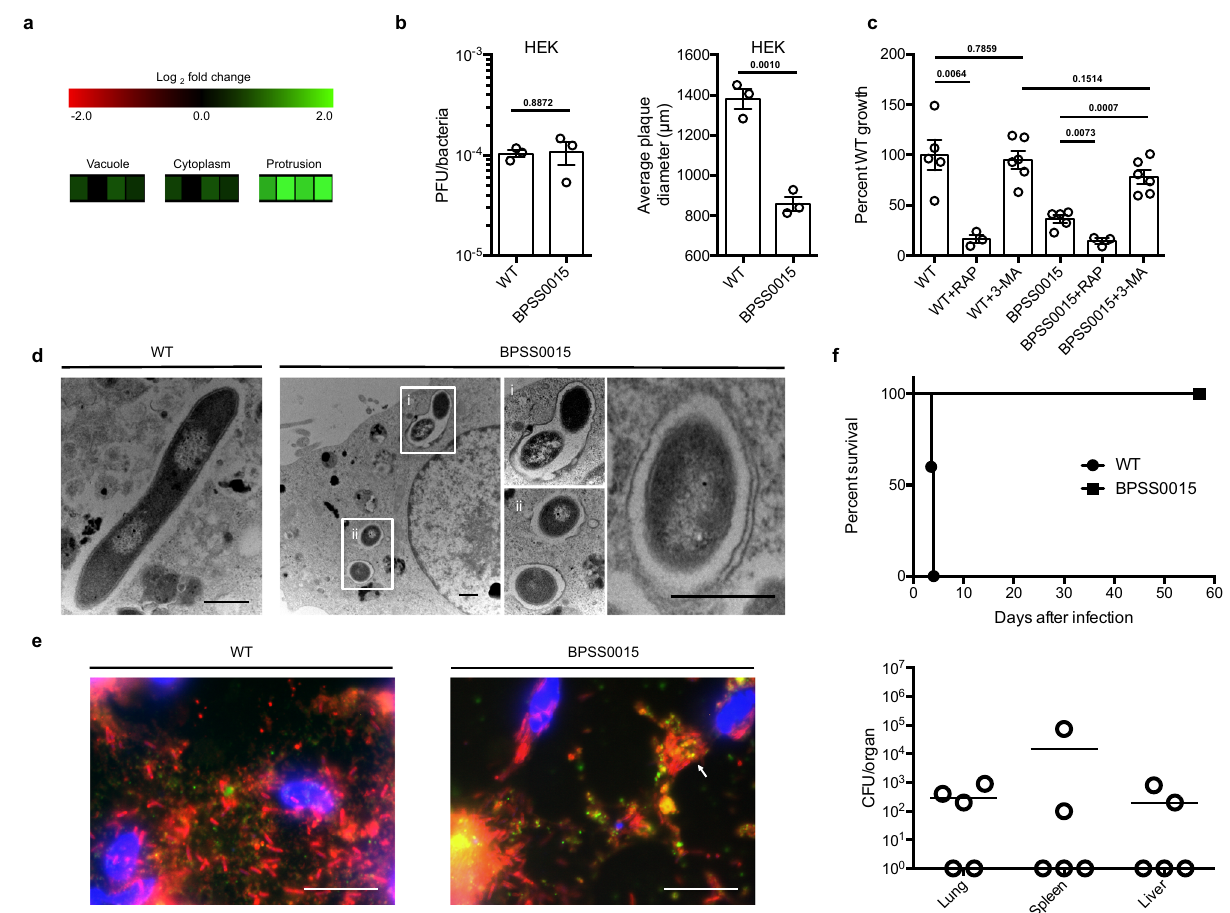
Fig. 4 Characterization of Bp mutant BPSS0015. a BPSS0015 is upregulated at the protrusion stage during infection. First three boxes of each infection stage represent three biological replicates, the fourth represents the mean. b Number of plaques formed (PFU) by the BPSS0015 mutant is similar to wild- type Bp , indicating no defects in host cell invasion; however, reduced plaque diameters were observed, suggesting defects during the progression of infection ( n = 3). c Rapamycin-induced (RAP) autophagy reduced the survival of both wild-type Bp and the BPSS0015 mutant ( n = 3), whereas the inhibition of autophagy with 3-methyladenine (3-MA) signi fi cantly restored intracellular replication of the BPSS0015 mutant to wild-type level ( n = 6). d Representative TEM images of macrophages infected with the BPSS0015 mutant show each bacterium surrounded by membrane structures. Scale bars = 1 μ m. e Infected HEK293T cells stably expressing GFP-LC3 show co-localization of the autophagy marker, LC3 (green), with the BPSS0015 mutant (red), indicated by the white arrow, and no co-localization with wild-type Bp (red). Scale bars = 10 μ m. f The BPSS0015 mutant is completely attenuated in BALB/ c mice ( n = 5) but bacterial burdens of surviving mice suggest that this mutant persists in vivo. Data in bar graphs represent means ± s.e.m. and analyzed via two-sided unpaired t- test. P values presented above relevant